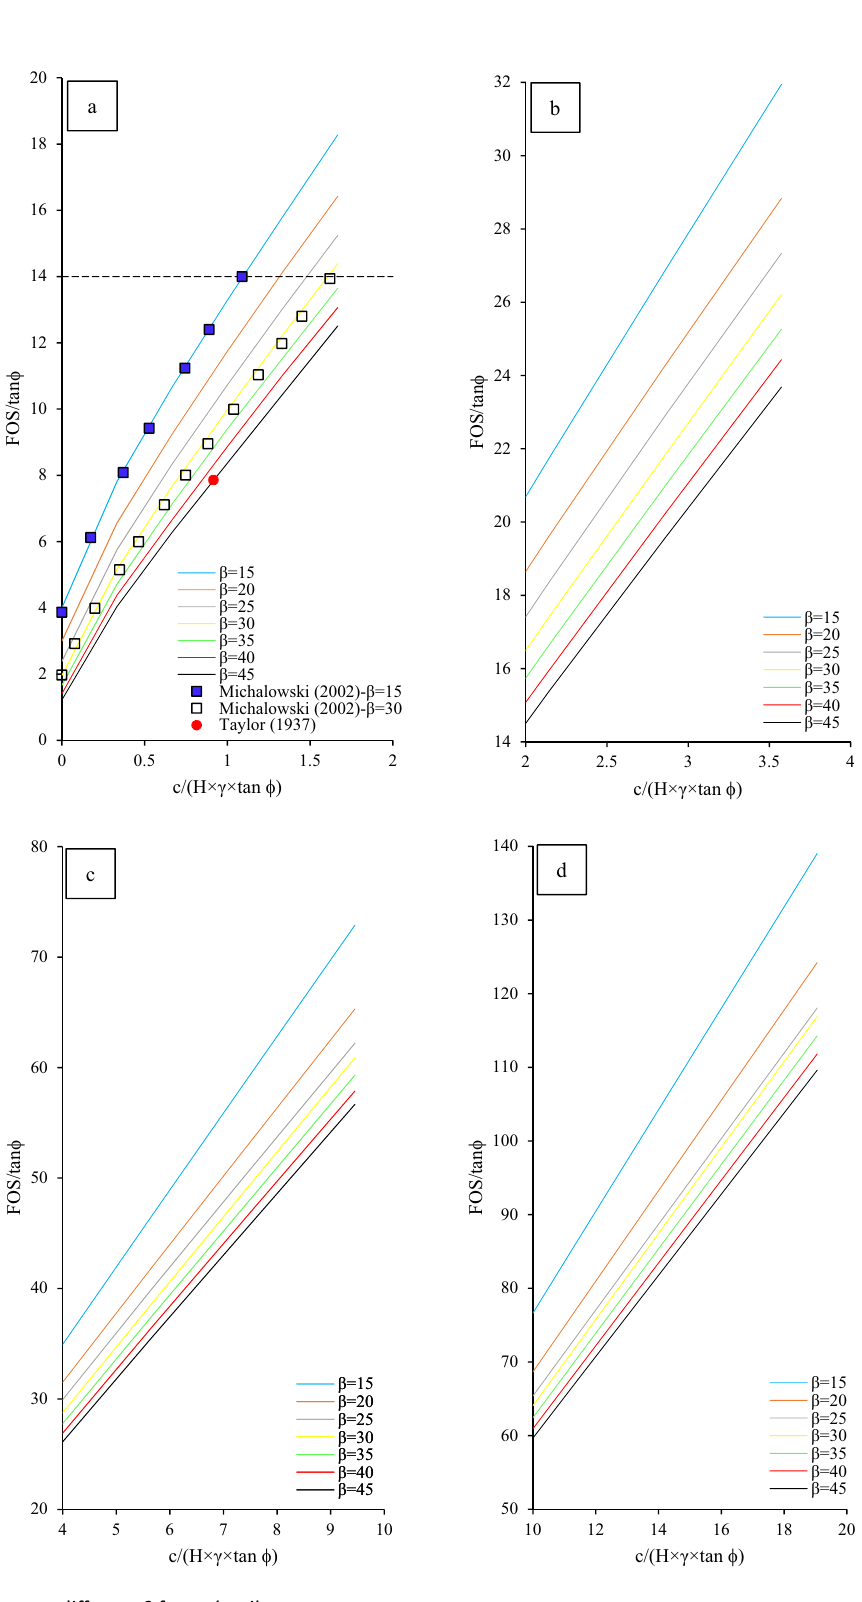
Figure 4: Design charts at di ff erent β for c – ϕ